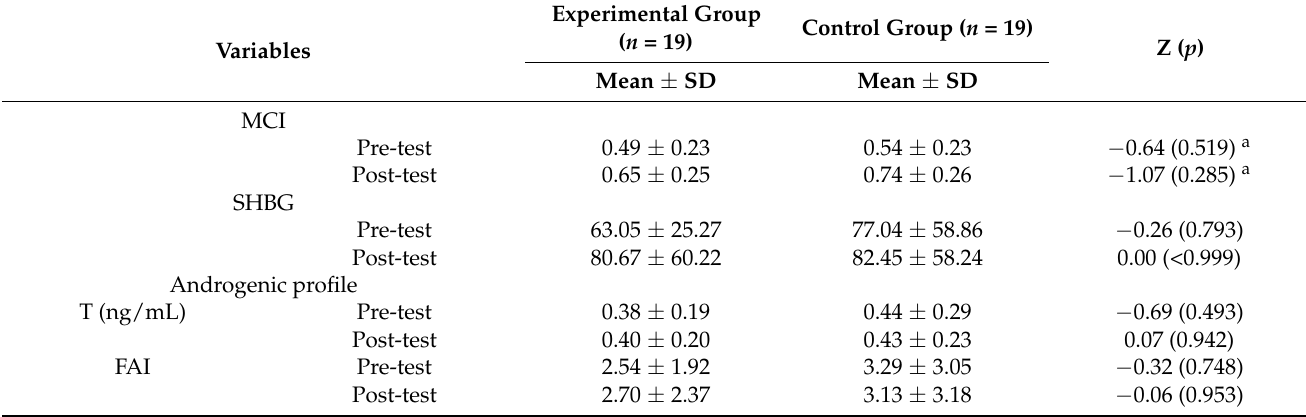
Table 2. Comparison of primary outcome variables in the experimental and control groups ( n = 38).